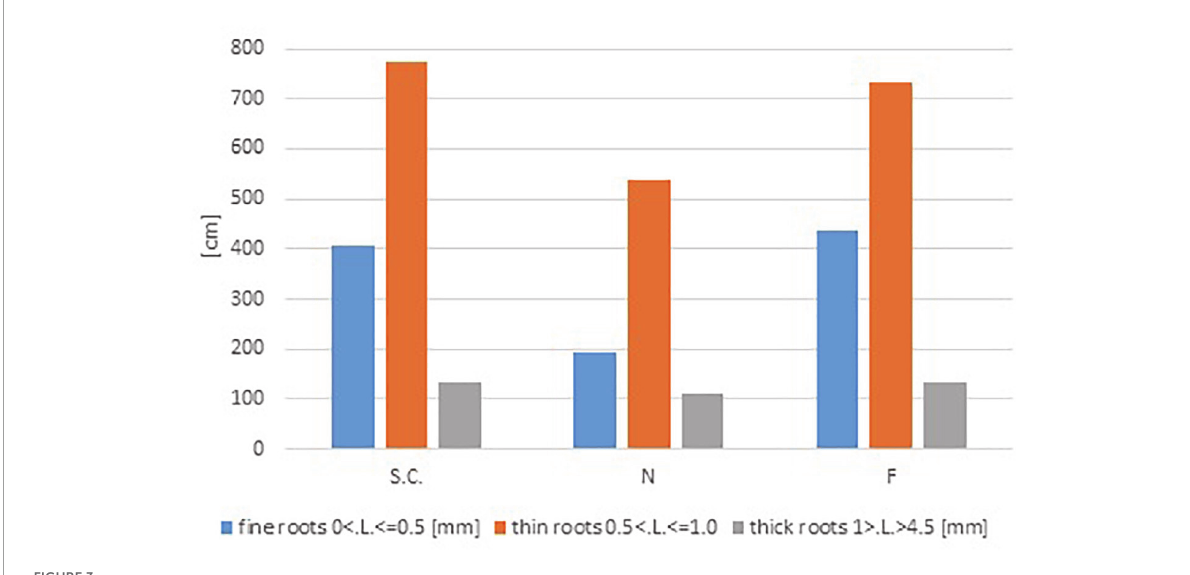
FIGURE3 Quantitative breakdown (cm.) of total root length for all variants studied. Results shown were divided into root thickness classes (mm.): blue represents fine roots; orange represents thin roots; gray represents thick roots.